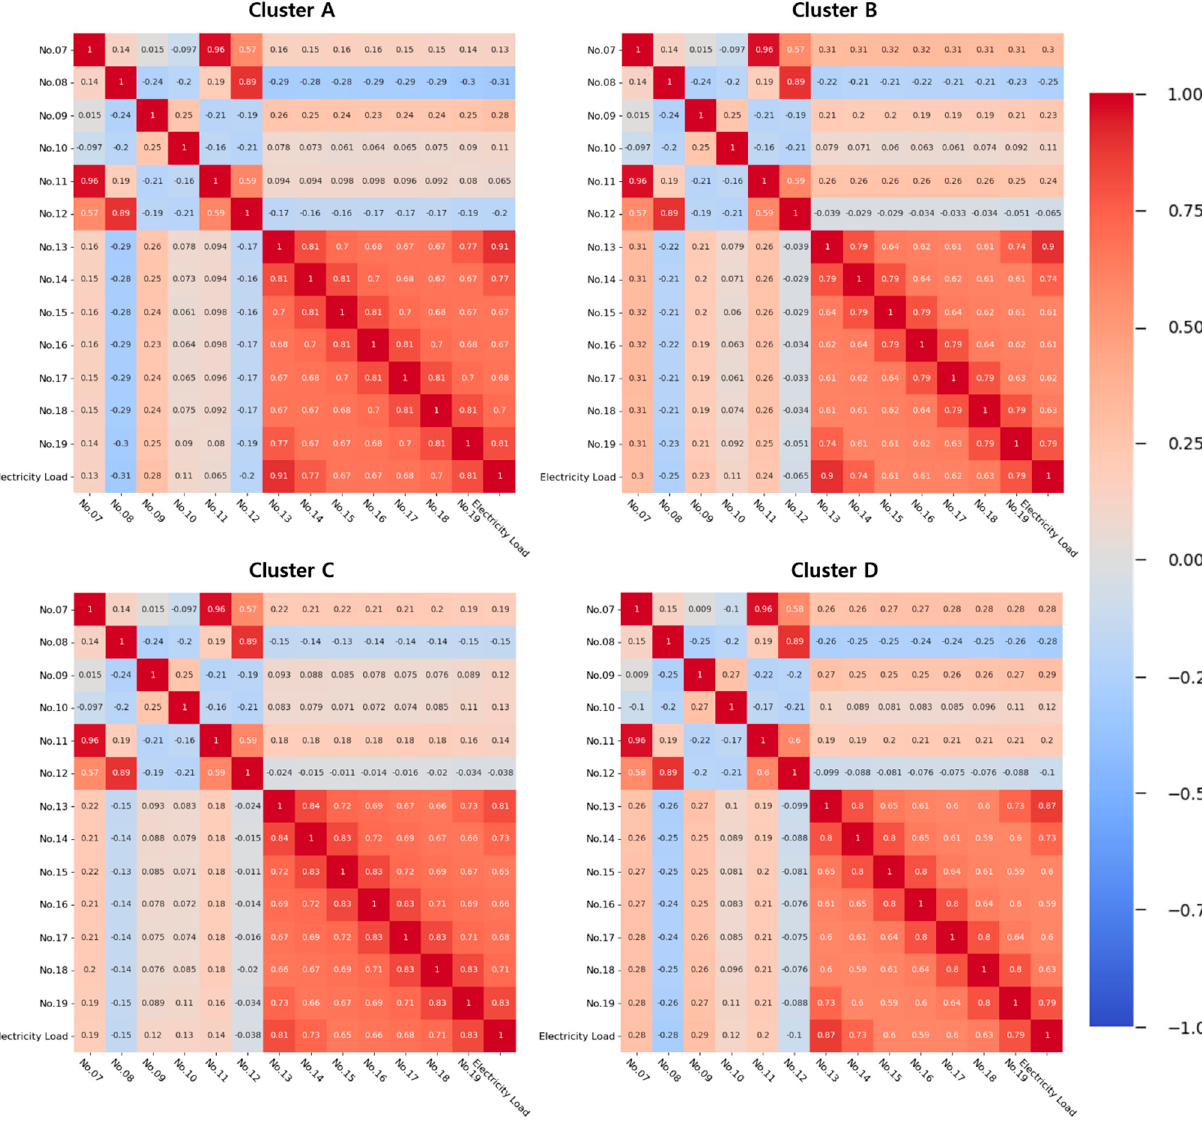
Figure 2. PCCs between input variables except calendar data and electricity load.